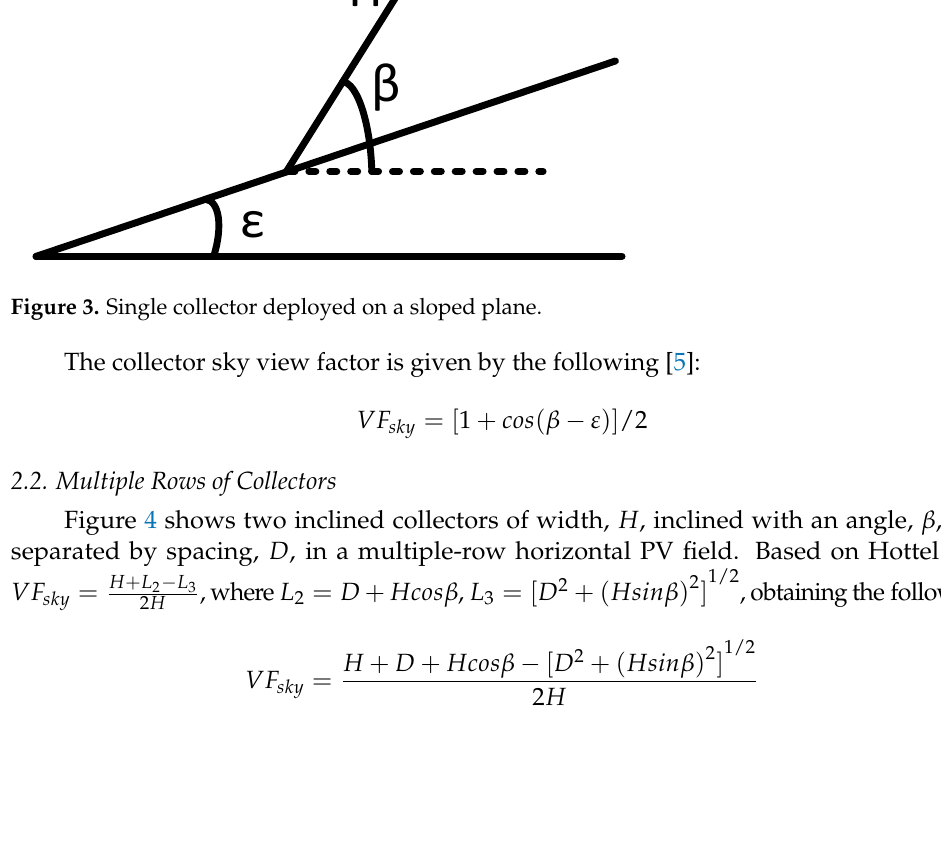
Figure 4. Multiple rows of collectors, 𝐻 , deployed on a horizontal plane.